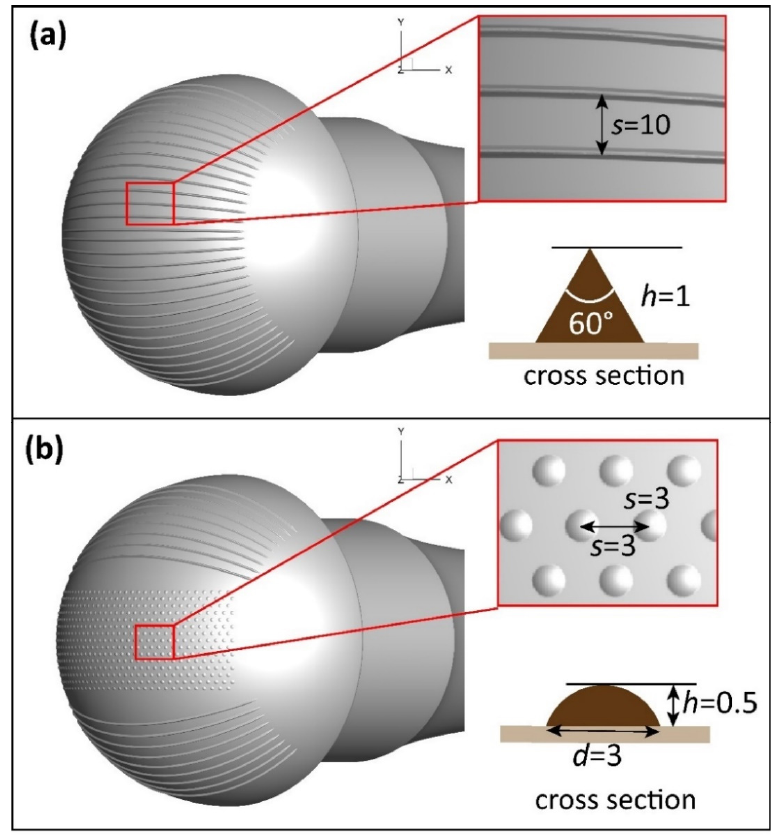
Figure 3. The helmet model with surface structure used in the CFD simulations; ( a ) the riblet structured helmet model, ( b ) the bumped helmet model.